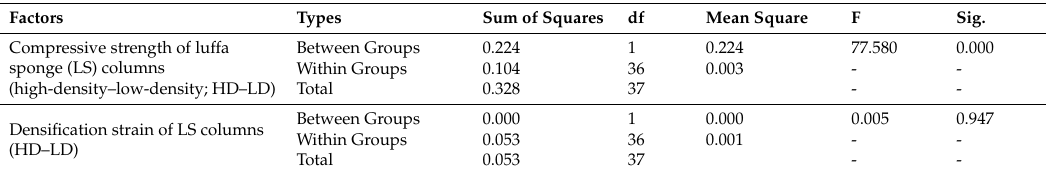
Table 1. Analysis of Variance (ANOVA) of compressive strength and densification strain of luffa sponge